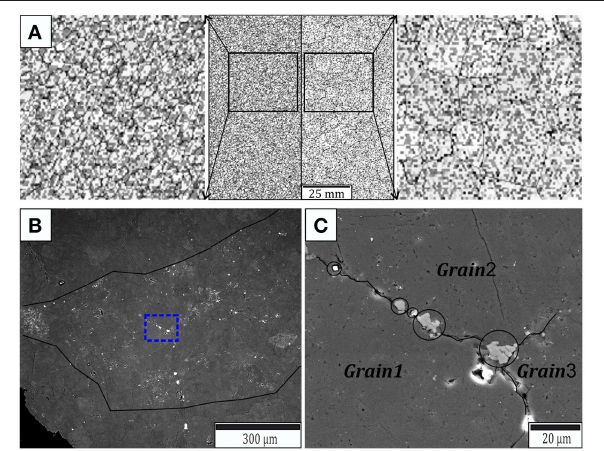
FIGURE 7 | (A) Particle redistribution during the simulation of anisotropic grain growth shown in Figure 5 . The left picture in (A) shows the initial impurity distribution and the right image shows the second-phase particle scatter after 10,000 time steps of the simulation. (B) Backscattered SEM image showing a fine grained layer in the center. The highest particle densities occur in the fine grained part which is indicated by the black line. (C) Combined backscattered and second-electron image showing the area indicated by the blue dotted line in (B) . Larger second-phase particles are lined up along the grain boundary (black circles) and the highest density of impurities is visible at the triple